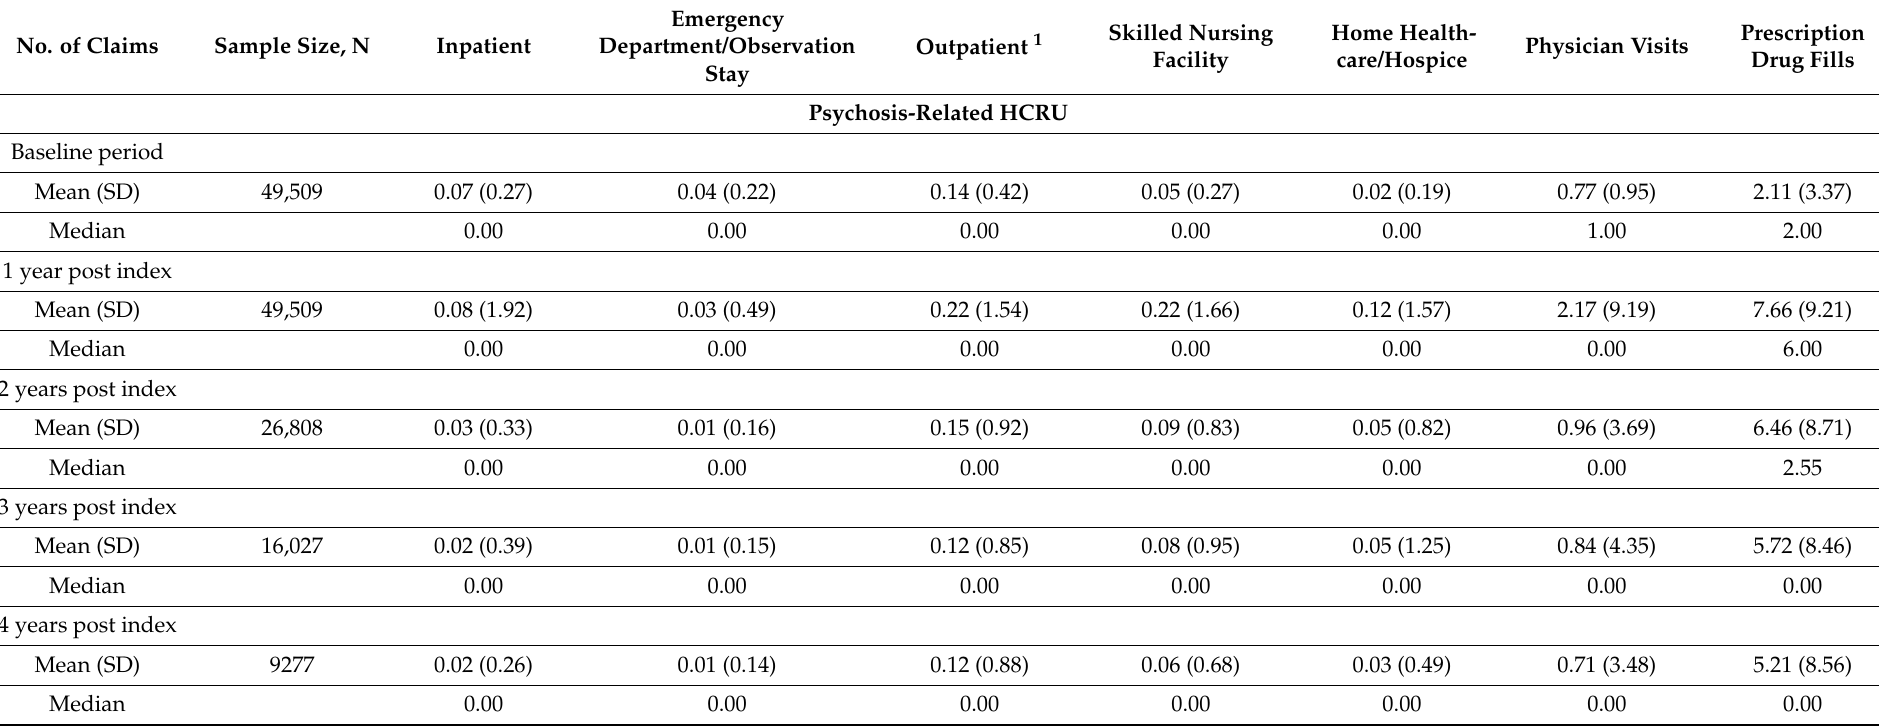
Table 2. Annualized psychosis-related unweighted HCRU claims per patient per year for patients with dementia-related psychosis.